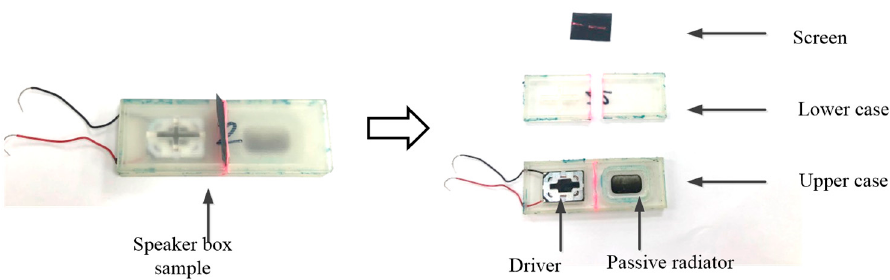
Figure 14. Components of speaker box with screen.